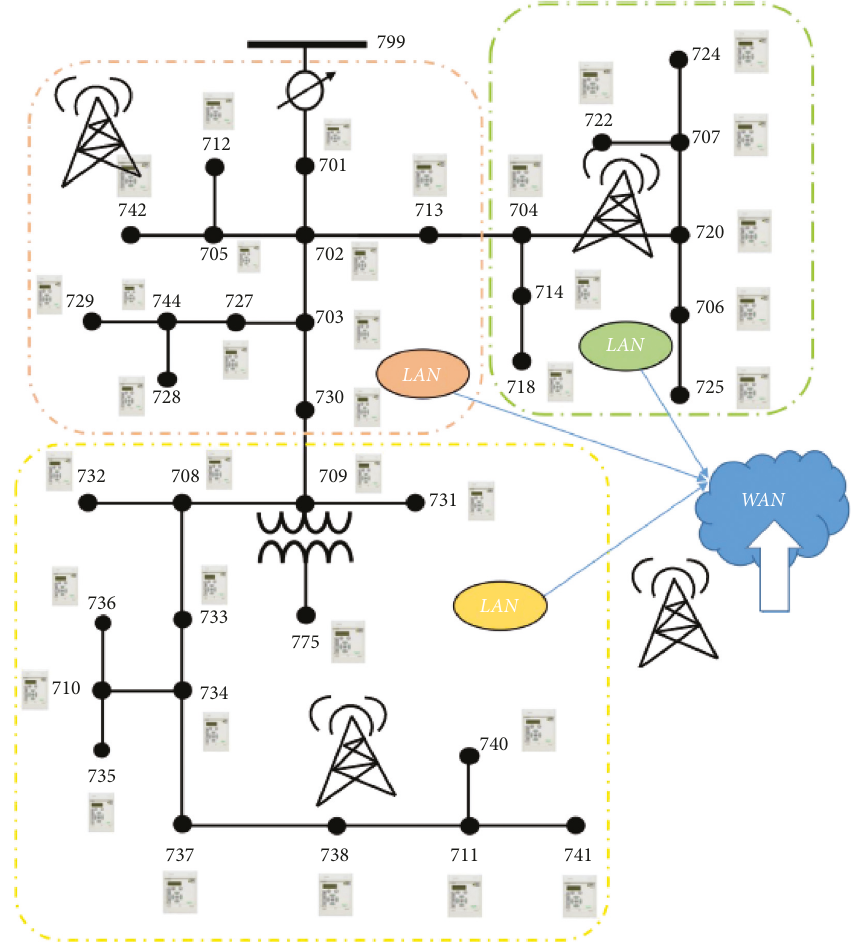
Figure 2: Intelligent IEEE 37-node